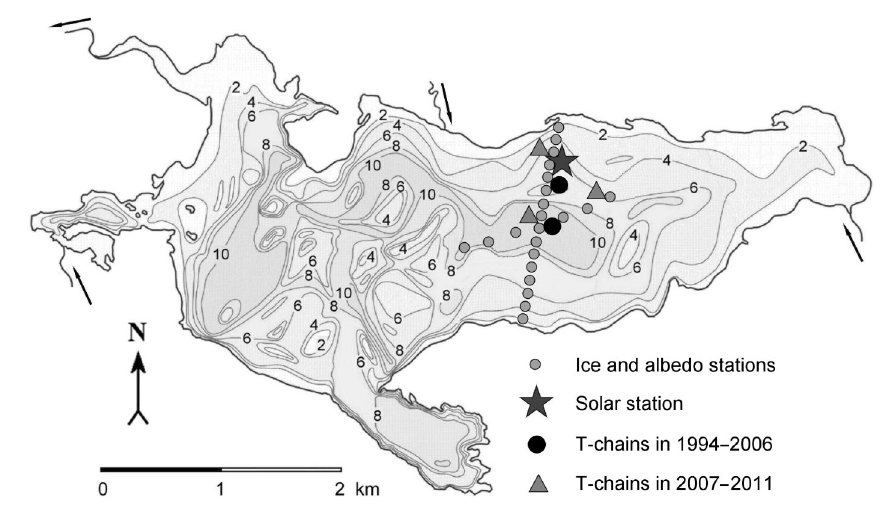
Fig. 1. Bathymetric map of Lake Vendyurskoe with location of the measurement